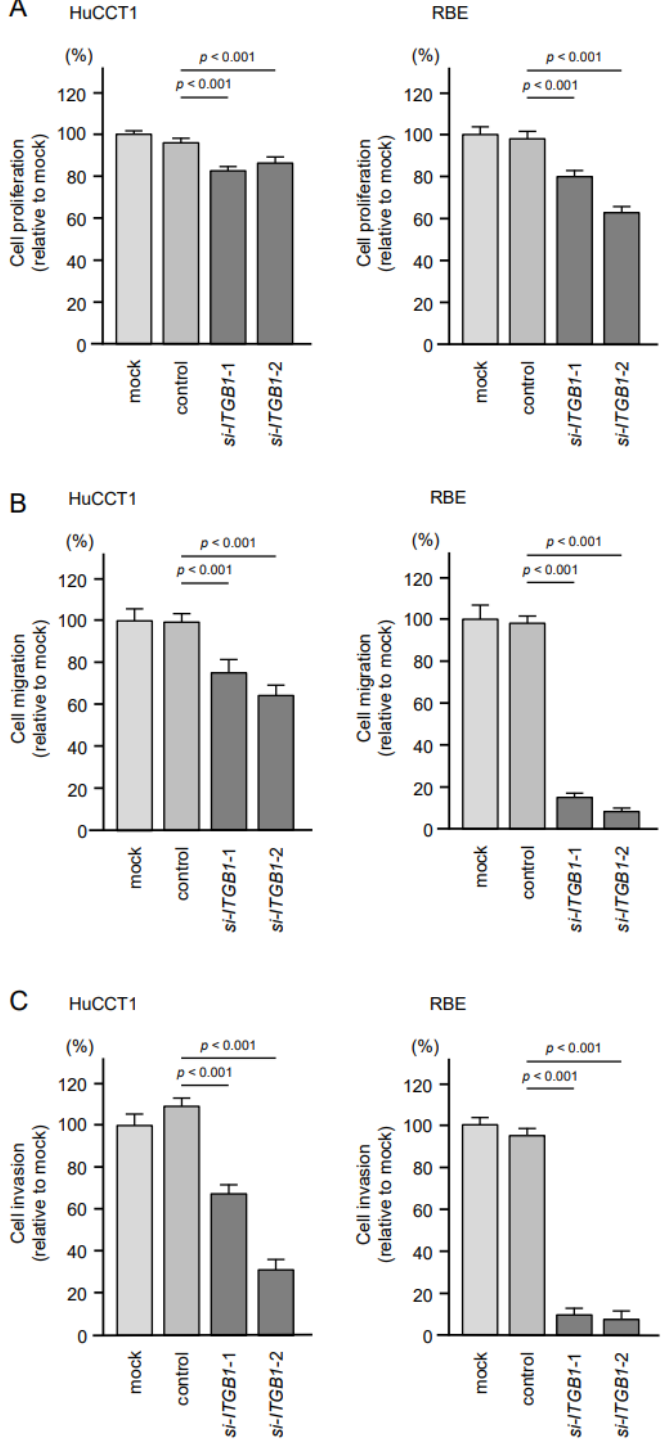
Figure 11. Effects of knockdown of ITGB1 on cell proliferation, migration and invasion in HuCCT1 and RBE. ( A ) Cell proliferation was assessed using XTT assays. Data were collected 72 h after miRNA transfection. ( B ) Cell migration was assessed using wound healing assays. ( C ) Cell invasion was determined 72 h after seeding miRNA-transfected cells into chambers using Matrigel invasion assays. Error bars are represented as mean ± standard error (SE).